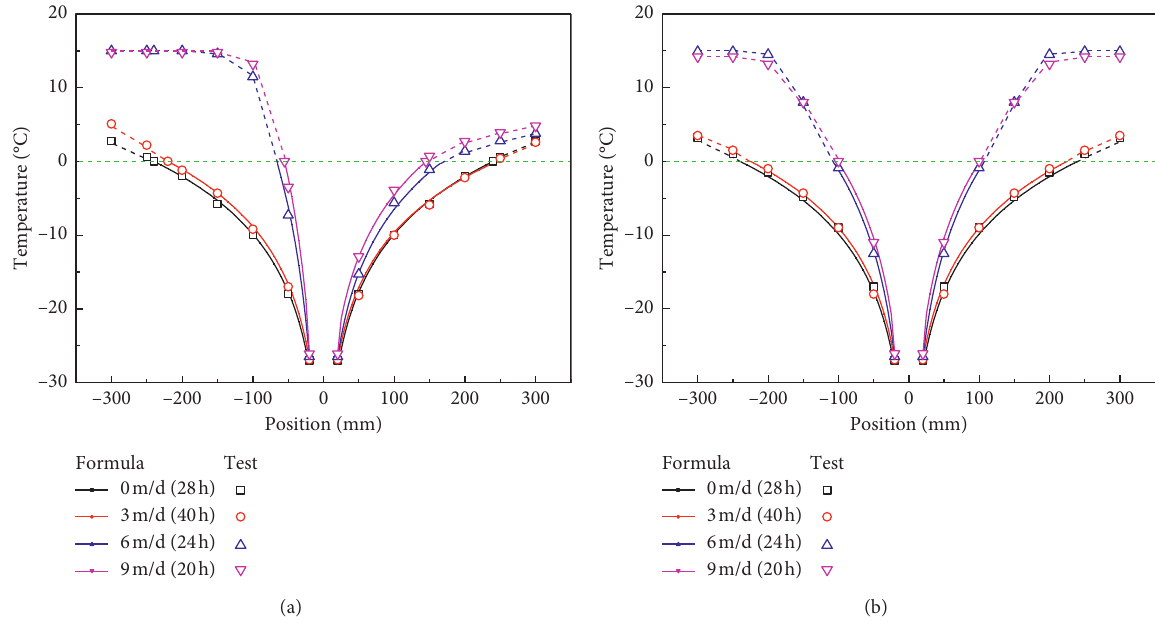
Figure 6: Comparison between formula calculation results and test results (a) parallel and (b) perpendicular to the direction of water flow.